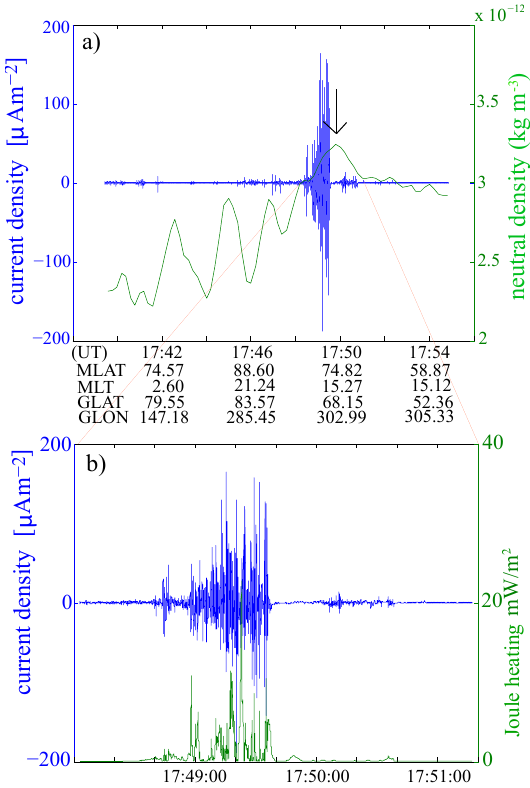
Figure 4. (a) CHAMP current and neutral density for 24 June 2009. (b) Estimated Joule heating for the E layer on 24 June 2009, with the CHAMP current density on the